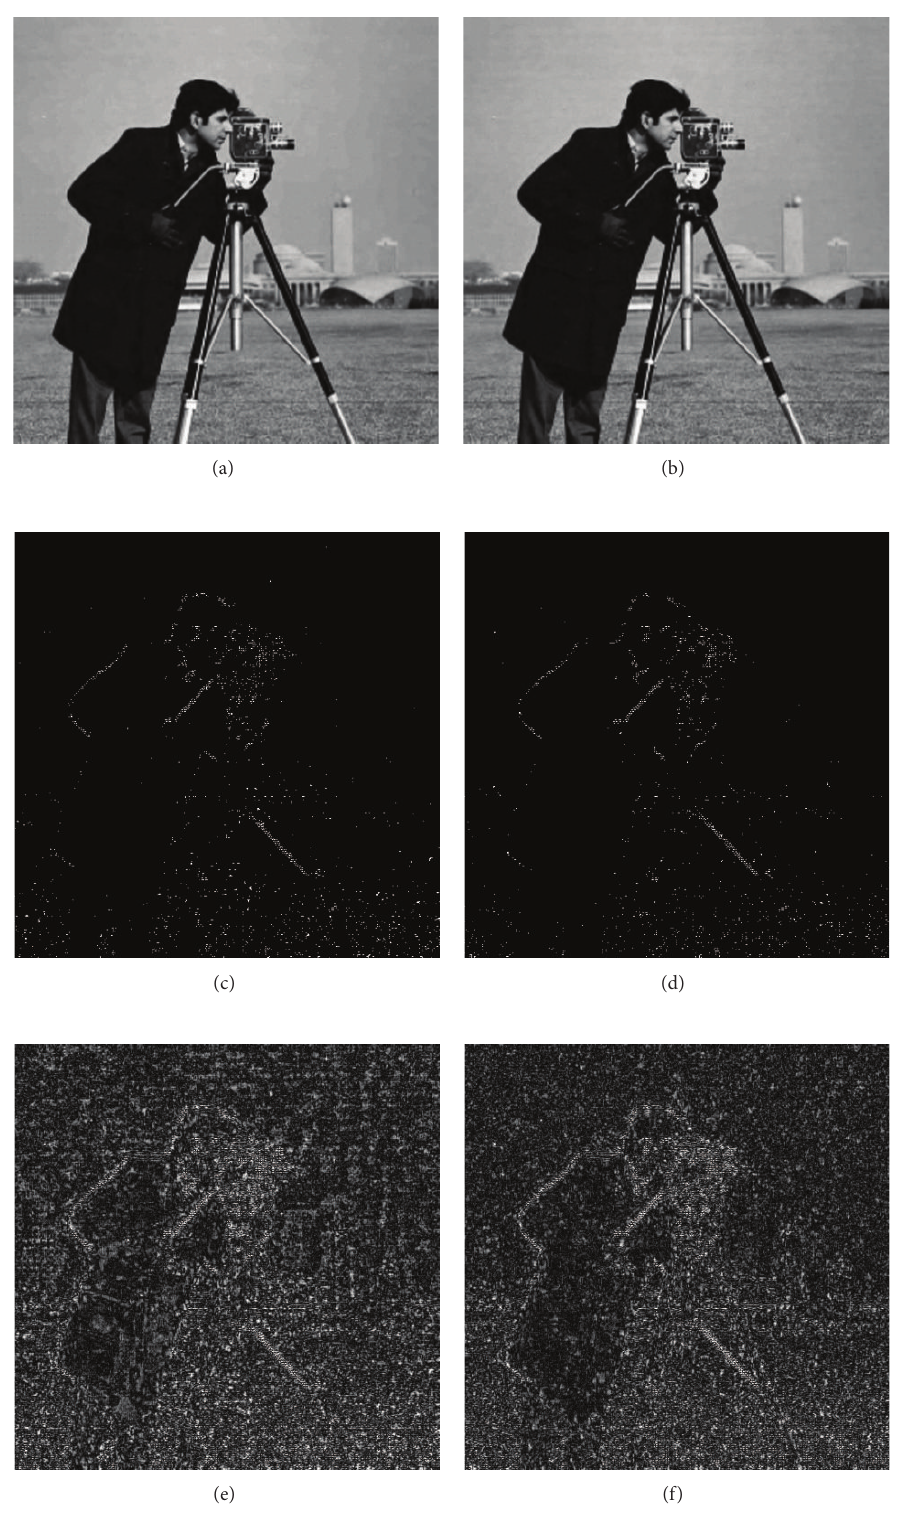
Figure 12: Comparison of evolved and CDF 9/7 filters. ((a), (b)) Reconstructed image using evolved and CDF 9/7 filter coefficients. ((c), (d)) Difference image using evolved and CDF 9/7 filter coefficients. ((e), (f)) Enhanced difference images for better